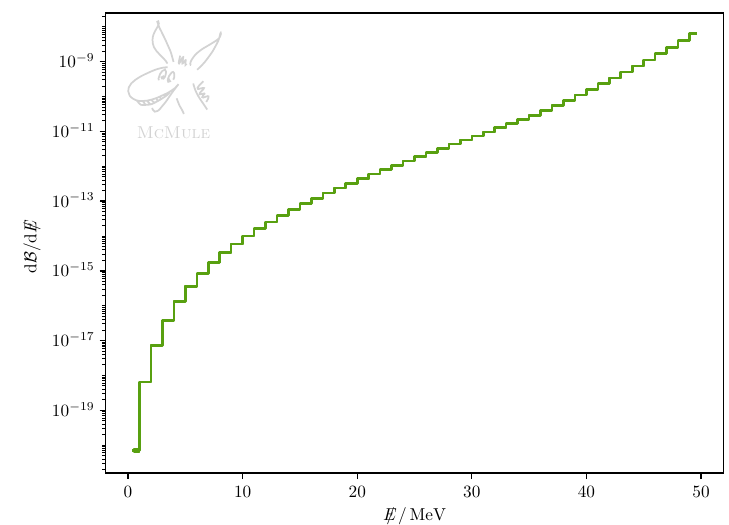
Figure 4: Branching ratio at LO for the double radiative muon decay µ → e ν ¯ νγγ , as a function of the missing energy, i.e. the energy of the